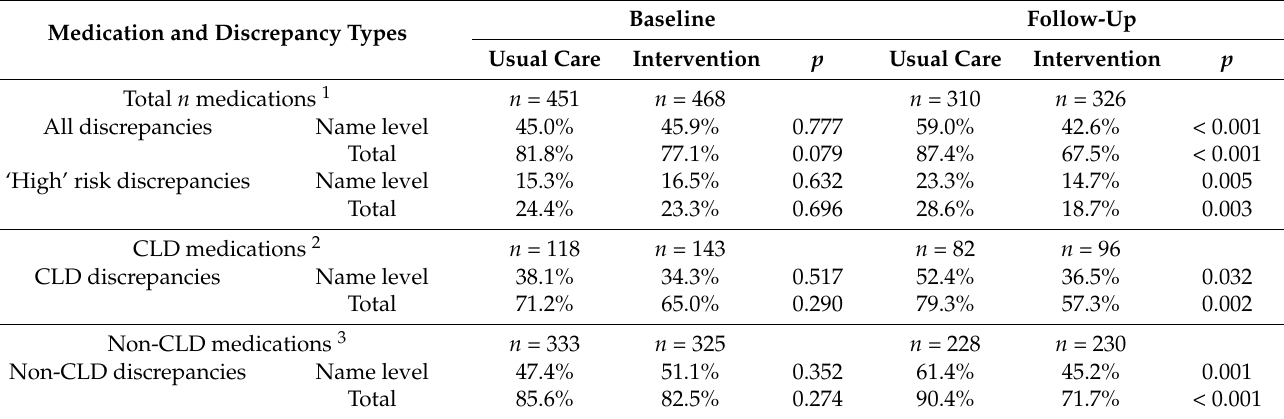
Table 3. Proportion of discordant medications within intervention and usual care groups at baseline and follow-up. Medication and Discrepancy Types